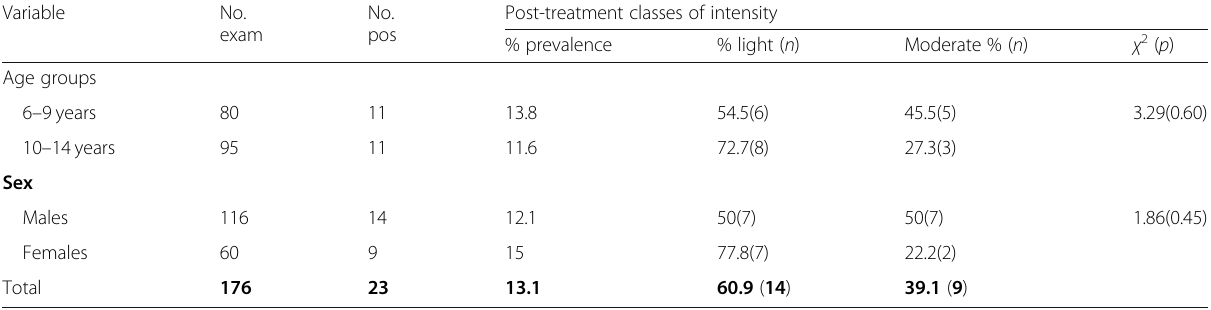
Table 3 Post-treatment prevalence (%) and proportion of classes of S. mansoni infection by age group and sex in Sanja General Elementary School children, Sanja town, Tacharmachiho district, Northwest Ethiopia, from March to April 2017 Variable No.